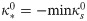
Analysis of fitted parameters.(a) Plot of most negative values of the intrinsic and actual meridional curvatures, κ*0=−minκs0 and κ* = −min κs against mean time ⟨t⟩. (b) Positions of posterior and anterior limits of the bend region relative to the undeformed sphere, plotted against mean time ⟨t⟩. Thick lines indicate straight line fits. Corresponding panels in Fig 7 are marked for some data points. See S1 Data for numerical values.